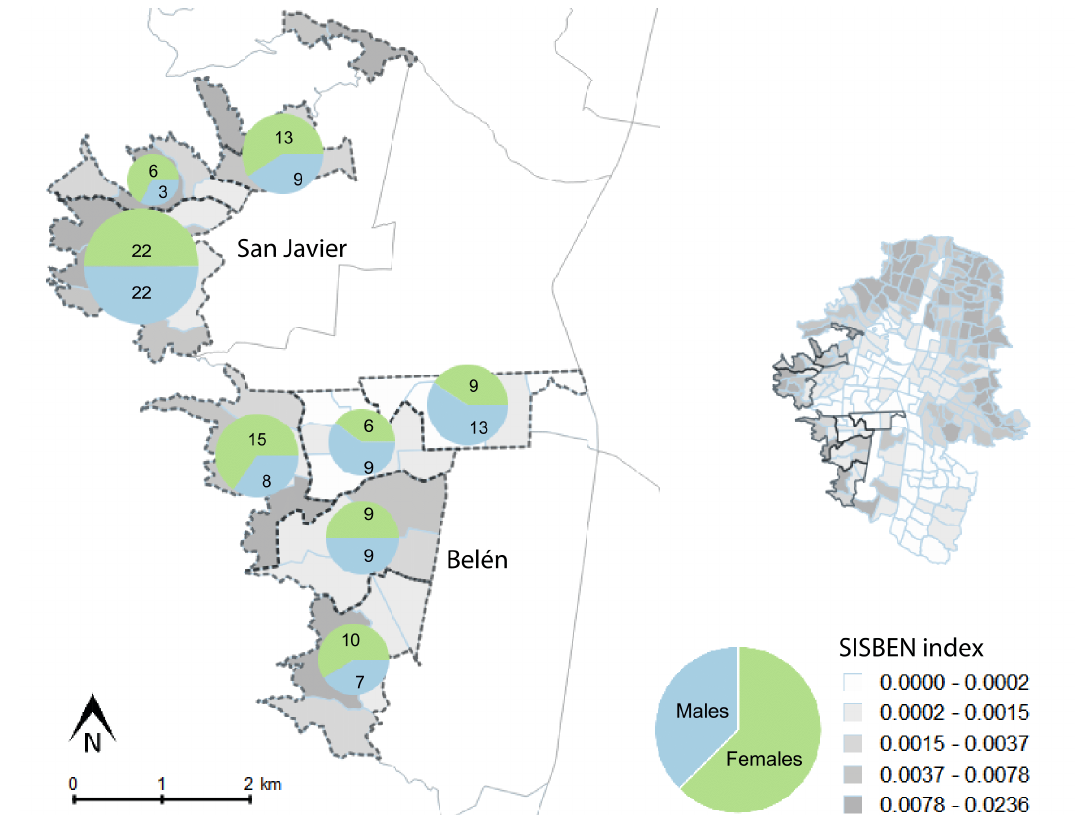
Figure 2. Locations of communities sampled over socio-economic status in Medellín, Colombia (based on an index derived from SISBEN surveys; low-to-high values shown on a dark-to-light ramp). Pie graphs displaying number and distribution of participants in each workshop